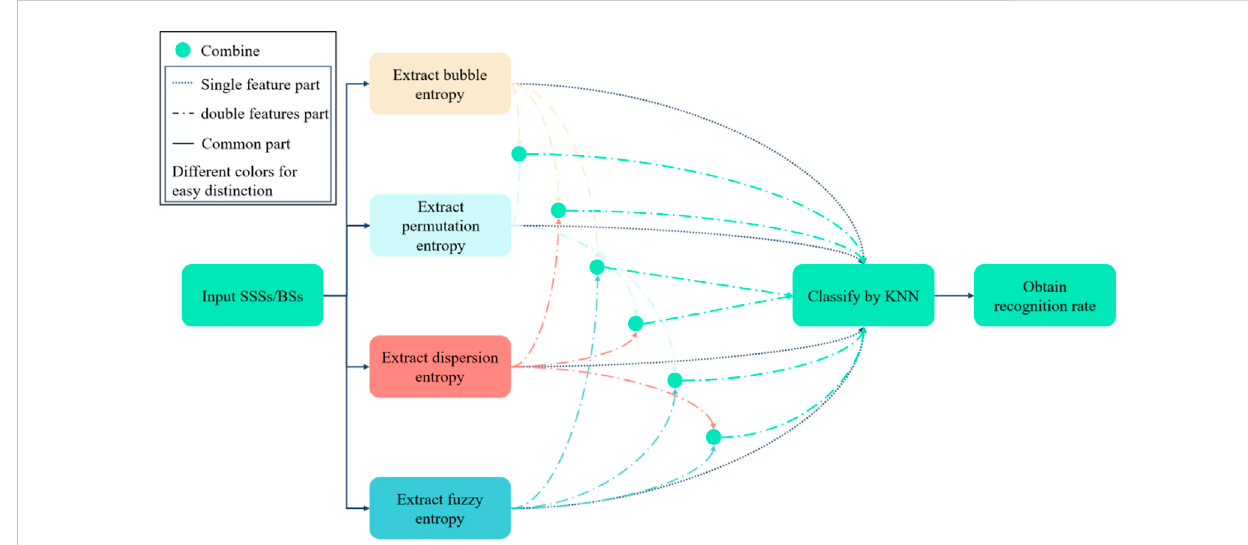
FIGURE 2 Flow chart of single and double feature extraction methods taken in this paper.